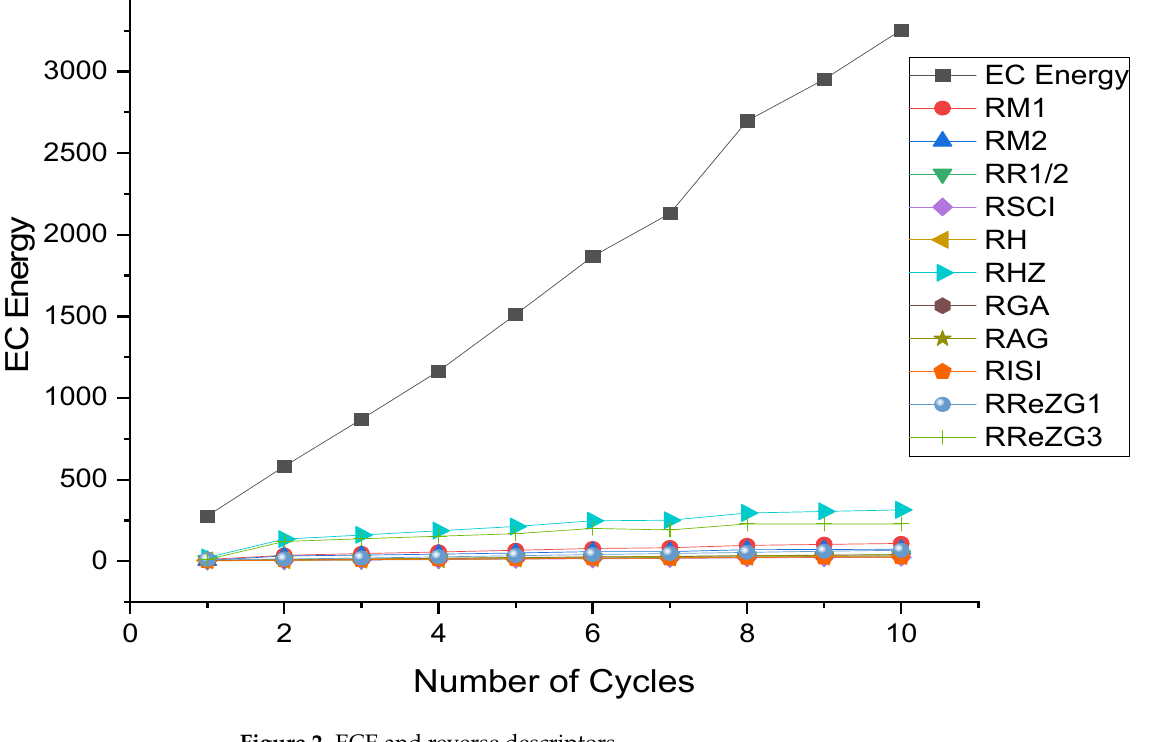
Figure 2. ECE and reverse descriptors.